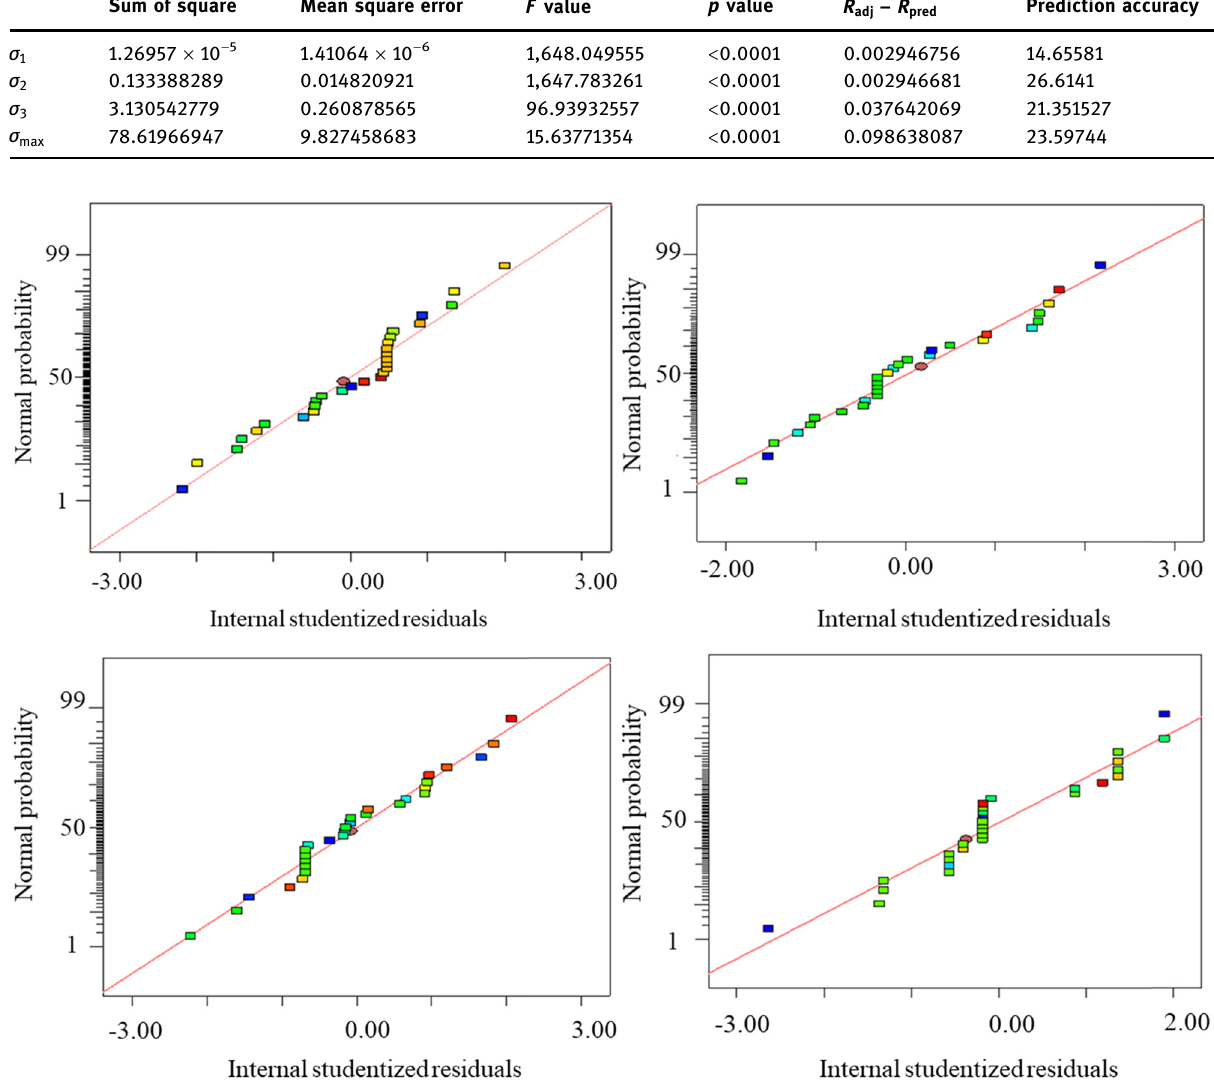
Figure 2: The normal distribution of the residuals of the regression model.